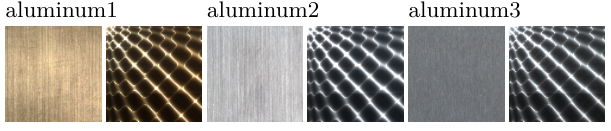
Fig. 14 Photographs of brushed aluminum samples and corresponding captured BRDFs. GT Baryc. RBF Ref. [2] Ours